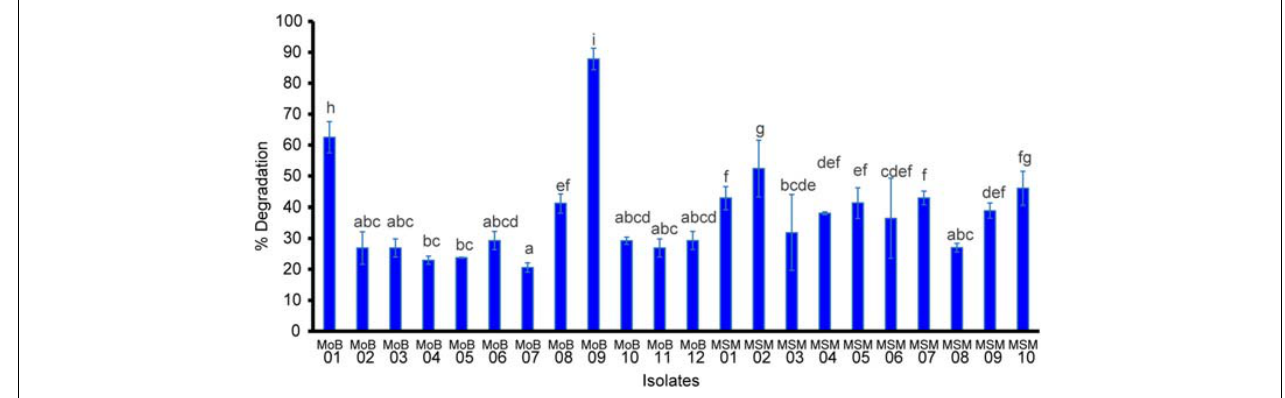
FIGURE 2 | Paraquat degradation of the selected isolates. Data were presented as mean ± SD of three replicas. Letters indicate a significant difference ( p < 0.05) using ANOVA with post hoc analysis.